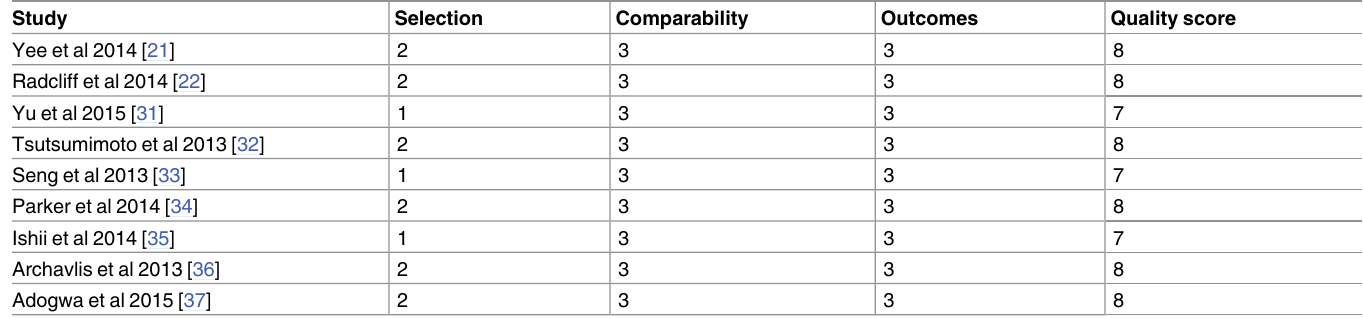
Table 3. Modified Newcastle-Ottawa Scale (NOS) scores for the included non-RCT studies.